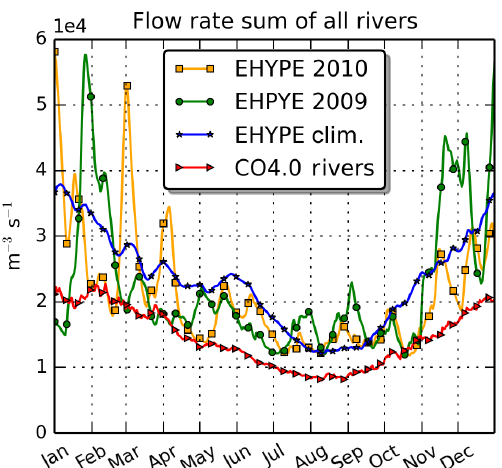
Figure 3. Comparison of total river flow rate between E-HYPE in- dividual years, 30-year mean and CO4 climatological